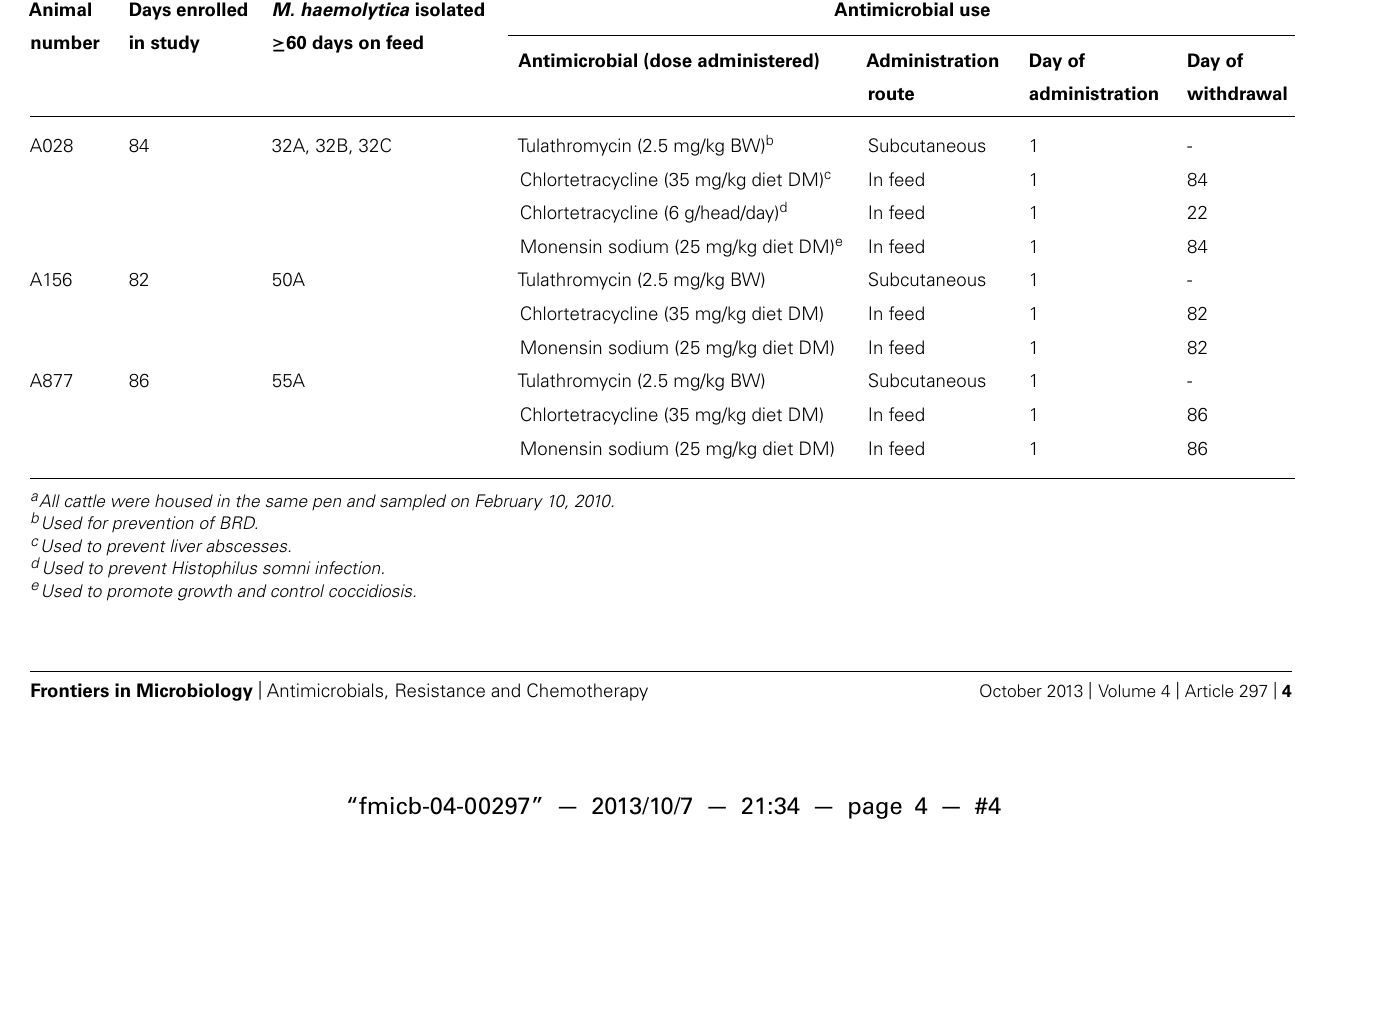
Table 5 | History of cattle colonized with tulathromycin-resistant M. haemolytica a . Animal Days enrolled number in